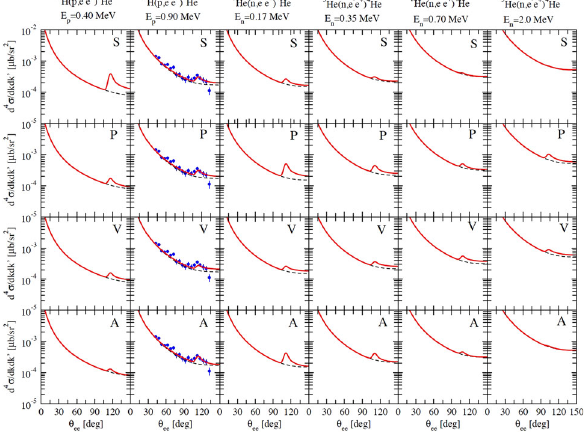
Fig. 16 Cross section for the 3 He ( n , e + e − ) 4 He and 3 H ( p , e + e − ) 4 He processes at six different incident nucleon energies as function of the angle θ e + e − between them. It is considered a configuration similar to the ATOMKI experiment one, in which the e + and e − momenta are in the plane orthogonal to the beam axis. The panels labeled S, P, V, and A show the results obtained by including the exchange of a scalar, pseu- doscalar, vector, and axial X17, respectively. In all cases, it is assumed M X 17 = 17 MeV / c 2 . The dashed (black) and solid (red) curves show the results obtained by including the electromagnetic only or both the electromagneticandX17amplitudes.Thecouplingconstantshave been adjusted so as to reproduce the ATOMKI 3 H ( p , e + e − ) 4 He cross sec- tion data at the incident proton energy of 0.90 MeV. See [67] for more details